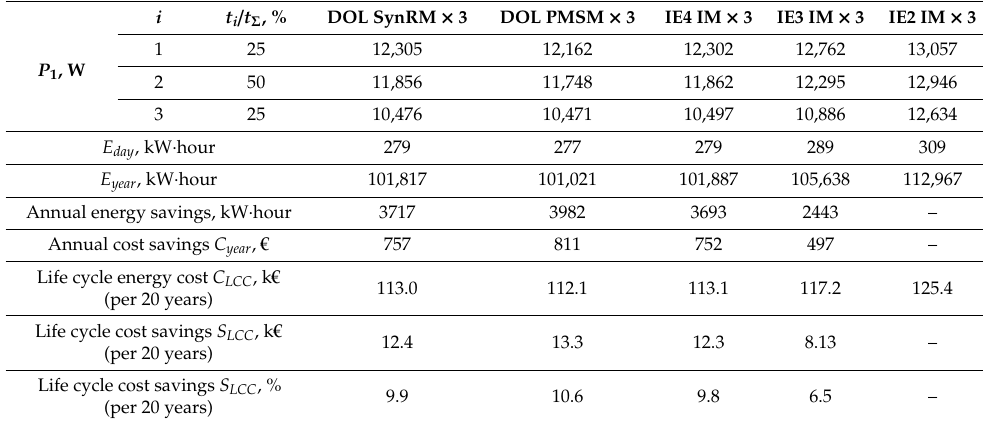
Table 7. Calculation of the energy consumption of three pump units considering the cable loss (case 2, m = 2).